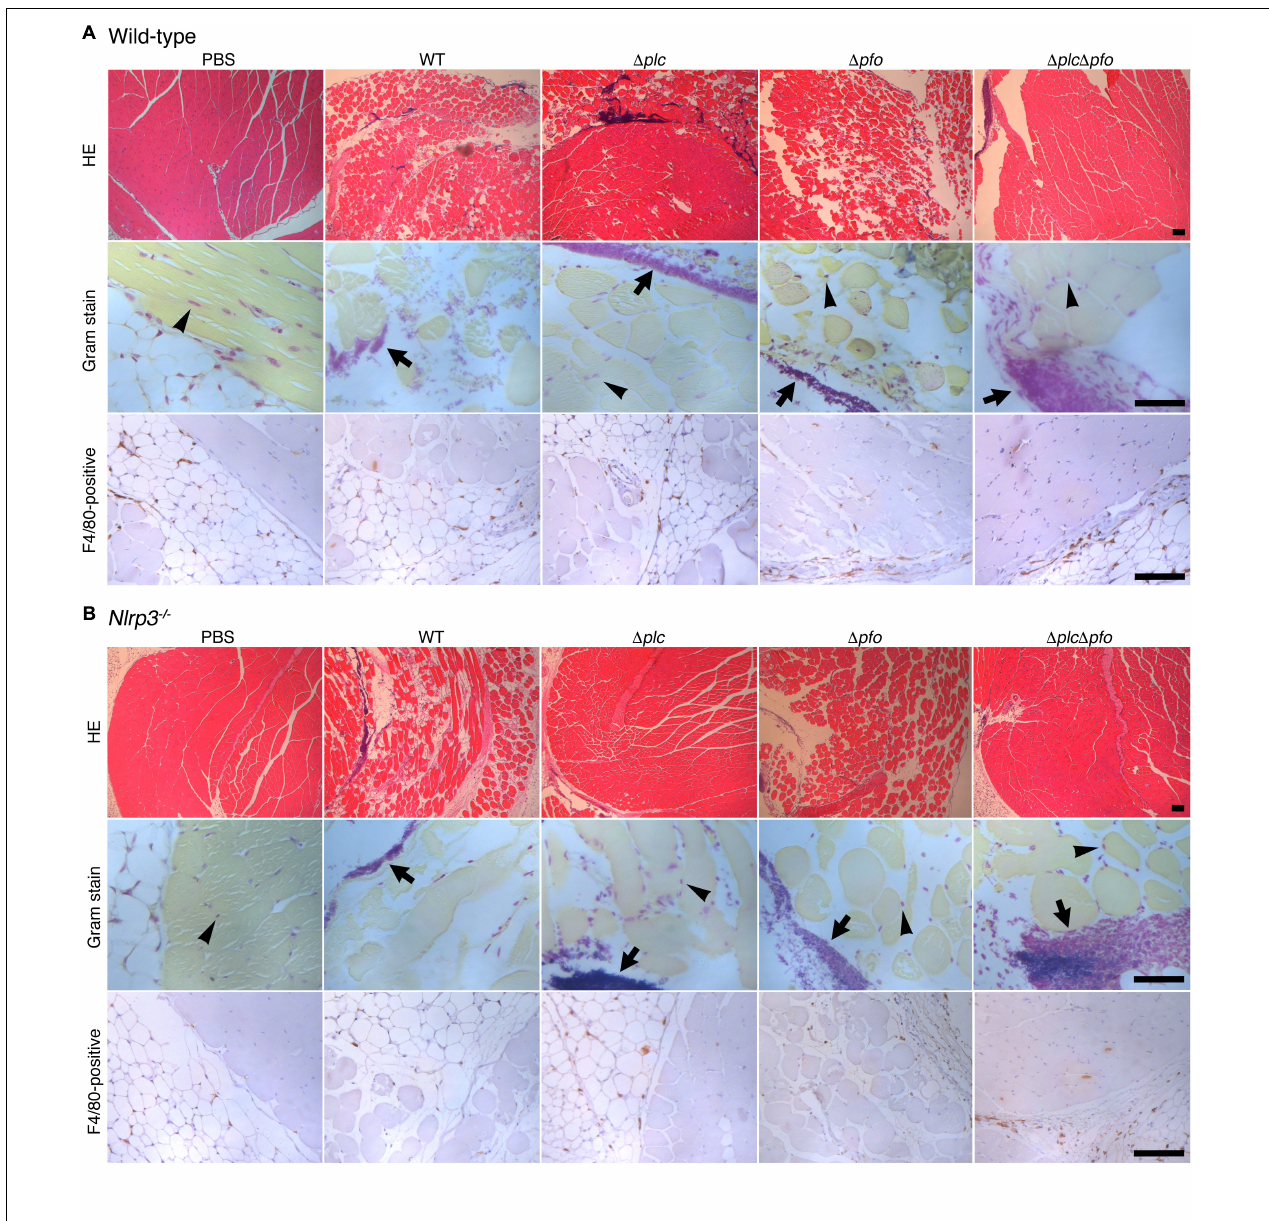
FIGURE 5 | PFO and NLRP3 are involved in part in the progression of myonecrosis in the muscle tissues infected by Clostridium perfringens . C57BL/6 wild-type (A) or NLRP3-deficient mice (B) (wild = type, n = 10 and gene- knockout mice, n = 8 for infection with WT C. perfringens , and n = 5 for infection with other mutants or incubation with PBS) were intramuscularly infected with WT C. perfringens and/or any of its isogenic mutants. The sections of infected muscle tissues at 6 hpi were analyzed by HE, Gram stainings and immunostainings with anti-F4/80 antibody to detect macrophage lineage. Representative data are shown. Black arrows indicate the infecting bacteria and black arrow heads indicate nonspecific staining to nuclei of myocytes. Bars, 100 µ m.